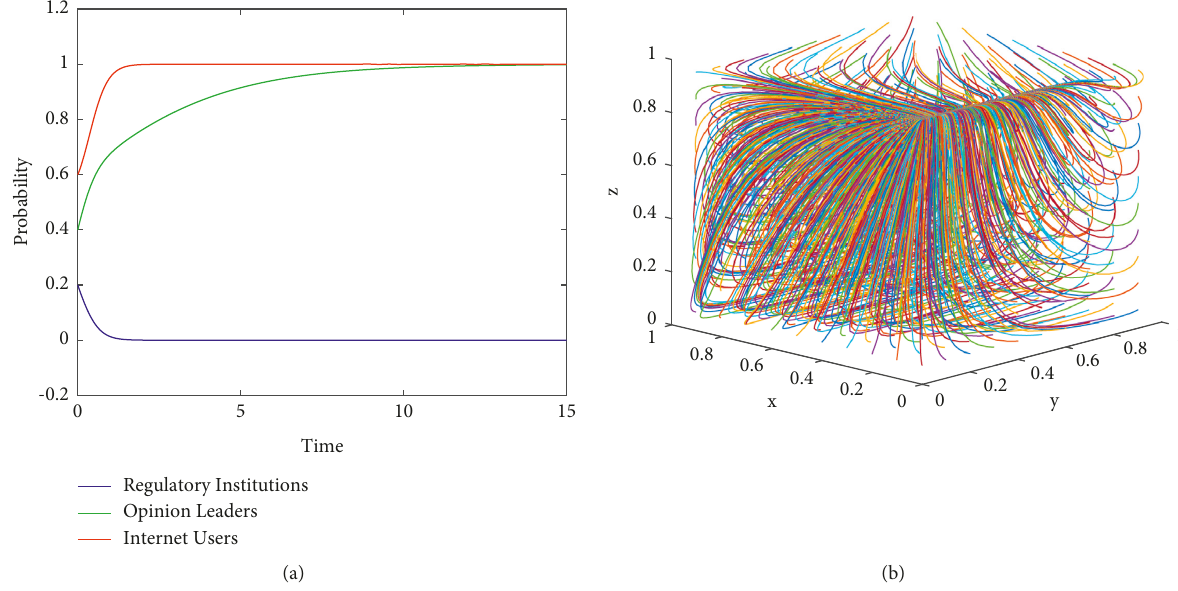
Figure 2: Tripartite evolutionary game trending figure stable at point E 4 (0,1,1) between “regulatory institutions, opinion leaders and Internet users.” (a) Strategy selection process. (b) 3D simulation diagram of the system.